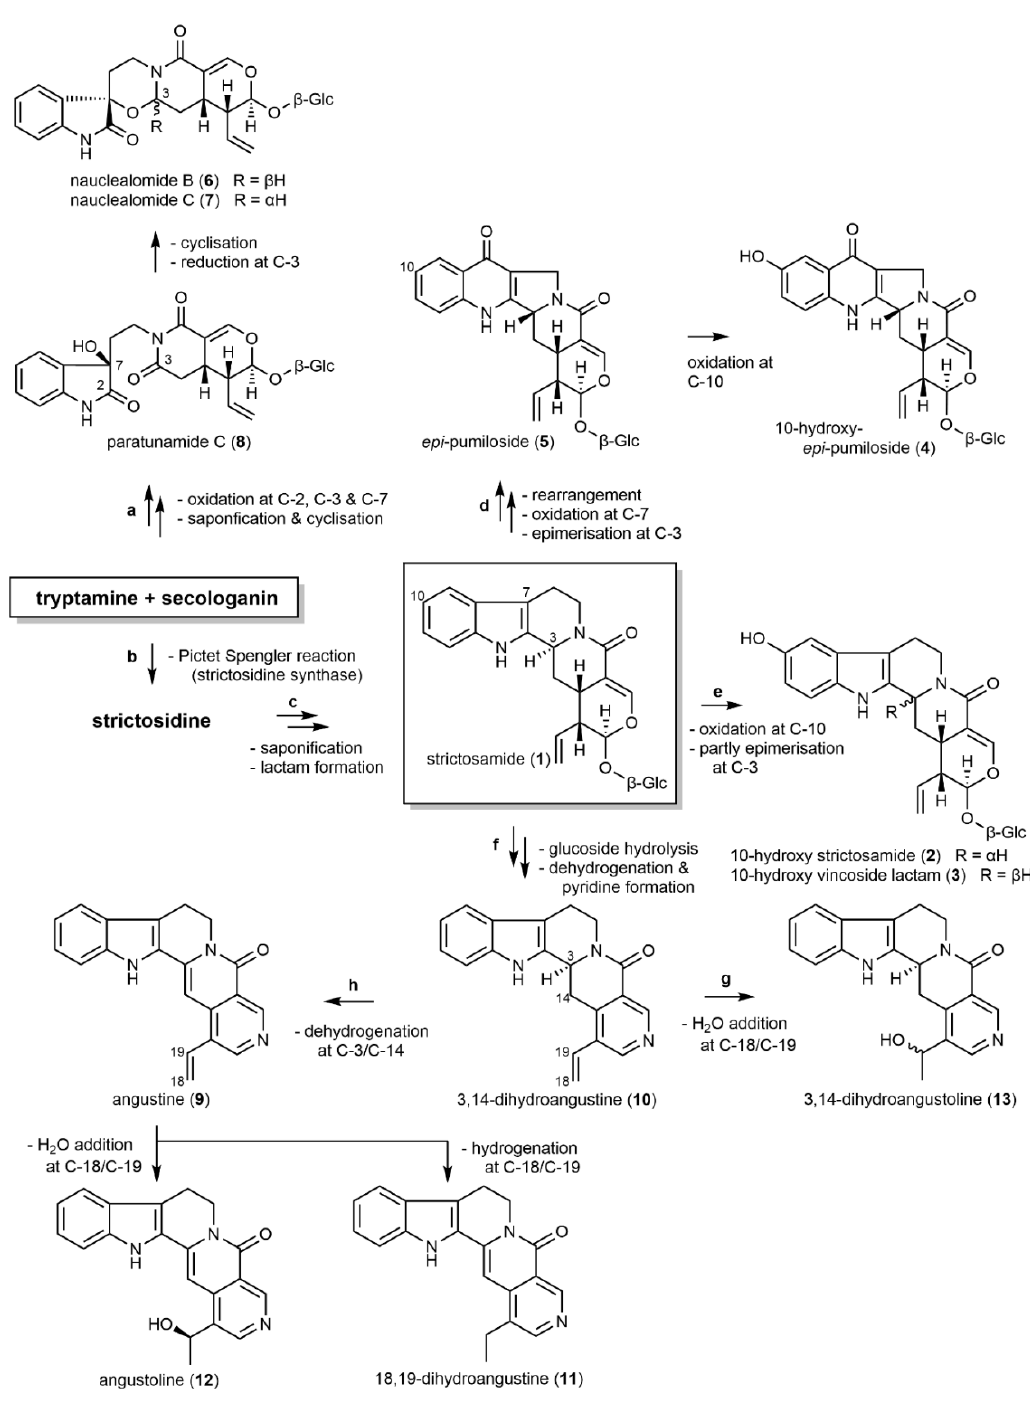
Figure 5. A possible biosynthetic pathway starting from tryptamine and secologanin leads on the one hand in a Pictet Spengler reaction to strictosidine, which is not accumulated in the plant (step b ) and then quantitatively converted in step c to accumulated strictosamide ( 1 ). Alternative to step a , an oxidation of position 2 in tryptamine can lead to the biosynthesis of paratunamide C ( 8 ), which can subsequently react further to nauclealomide B ( 6 ) and nauclealomide C ( 7 ) as described by [9]. Furthermore, starting from strictosamide ( 1 ), on the other hand, epi -pumiloside ( 5 ) (step d ) and sub- sequently 10-hydroxy epi -pumiloside ( 4 ) can arise according to [35]. A comparable oxidation of 1 leads to 10-hydroxy strictosamide ( 2 ) as well as to the epimeric 10-hydroxy vincoside lactam ( 3 ) in step f . The other alkaloids can be formed by deglucosylation. In this pathway, compound 1a is prob- able intermediate within step f , which is, however, not accumulated due to its reactivity. In the isolated secondary follow-up products 9 to 13 have a pyridine moiety present, which maybe formed in a cyclization, likely similar to those in the Kröhnke reaction [36]. In particular, structural